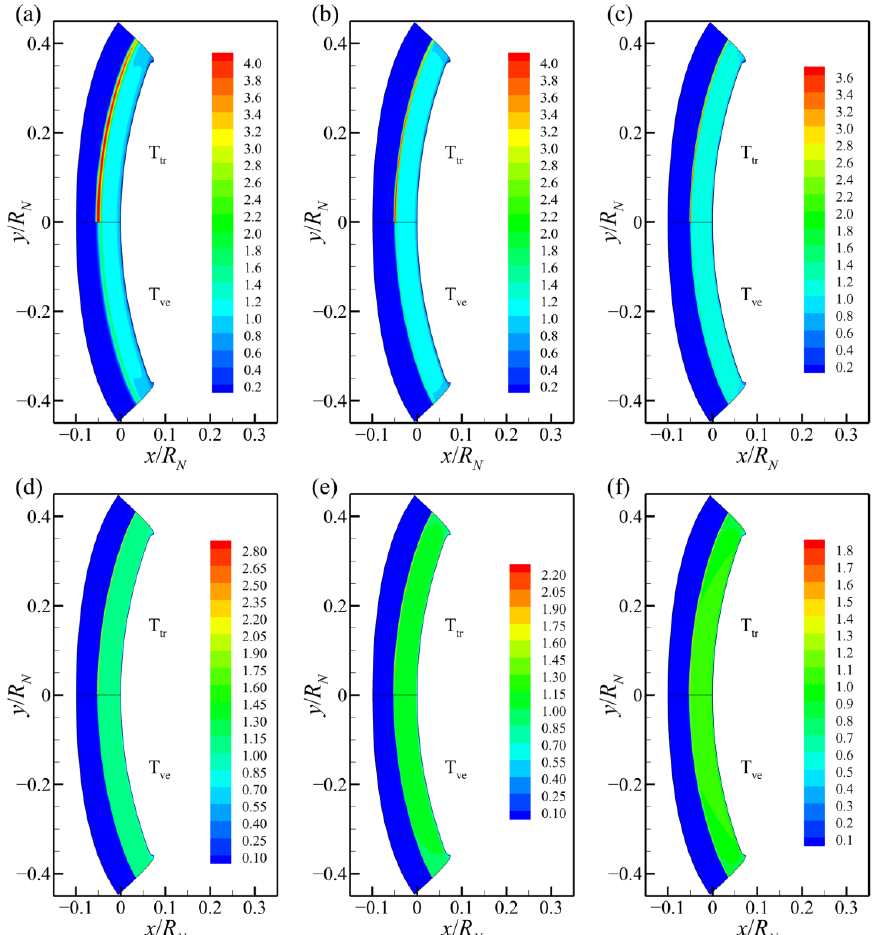
Figure 5. Temperature distribution in the Fire II flowfield (unit: 10 4 K): ( a ) t = 1634 s; ( b ) t = 1636 s;( c ) t = 1637 s; ( d ) t = 1640 s; ( e ) t = 1643 s; ( f ) t = 1645 s.